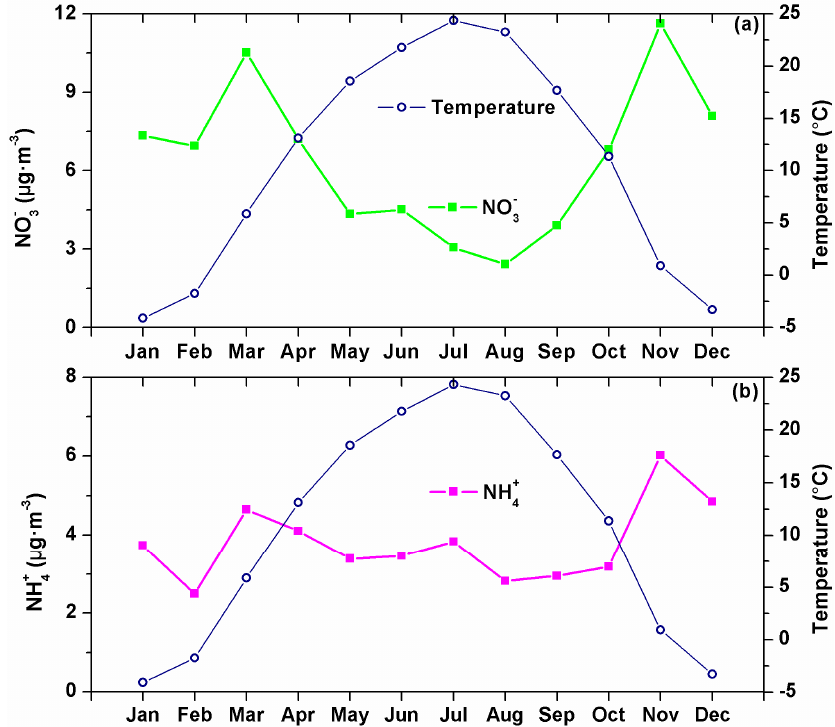
Figure 2. Relationships between NO 3 − and ambient temperature ( a ) and NH 4+ and ambient temperature ( b ).